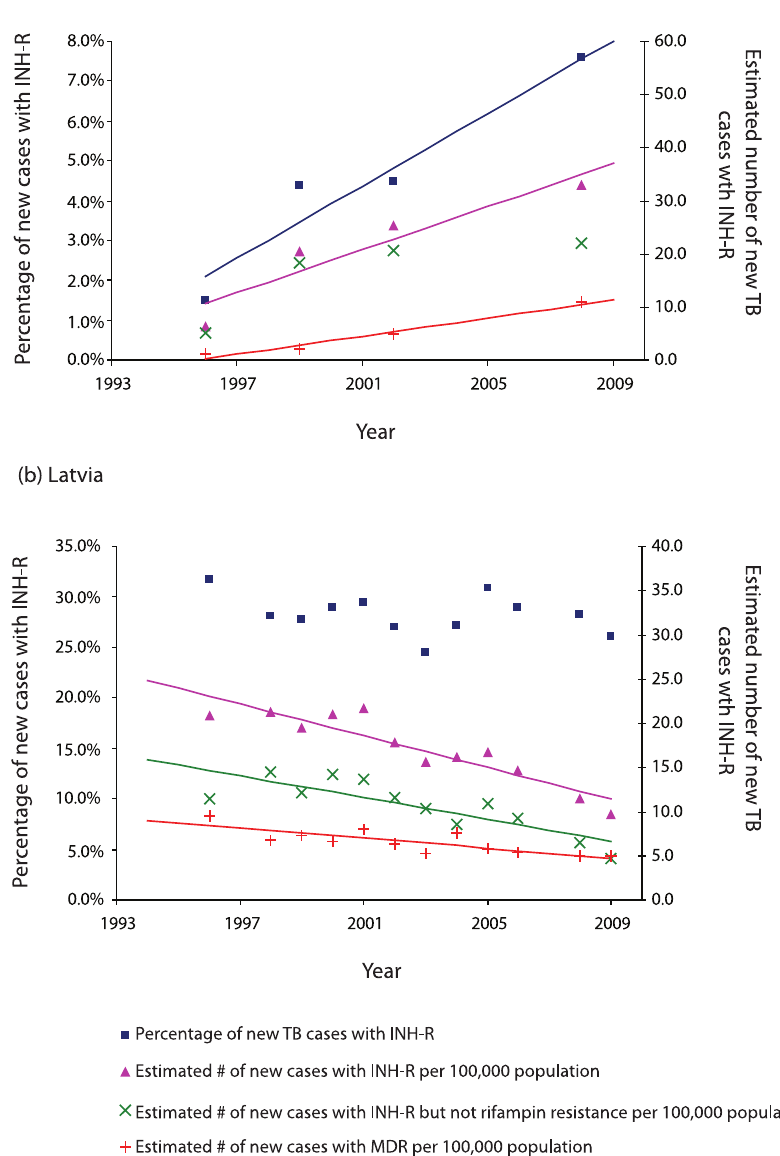
Figure 4. Percentage and number of new TB cases with isoniazid-resistant TB in (a) Botswana and (b) Latvia. Markers indicate reported data. The numbers with INH-R per 100,000 population (pink triangles) are also subdivided into those with MDR (red ‘ + ’ symbols) and those with INH-R without rifampin resistance (green ‘X’ symbols). Data points for the percentage of TB cases with INH-R are marked by blue squares. Lines indicate fitted linear trends and are only displayed where a significant linear trend was found (p , 0.1). The colour of the line matches the colour of the data points to which the linear trend is fitted. Note that scales are different between (a) and (b) and that there are two y-axes, one for the percentage and one for the number of TB cases with INH-R per 100,000